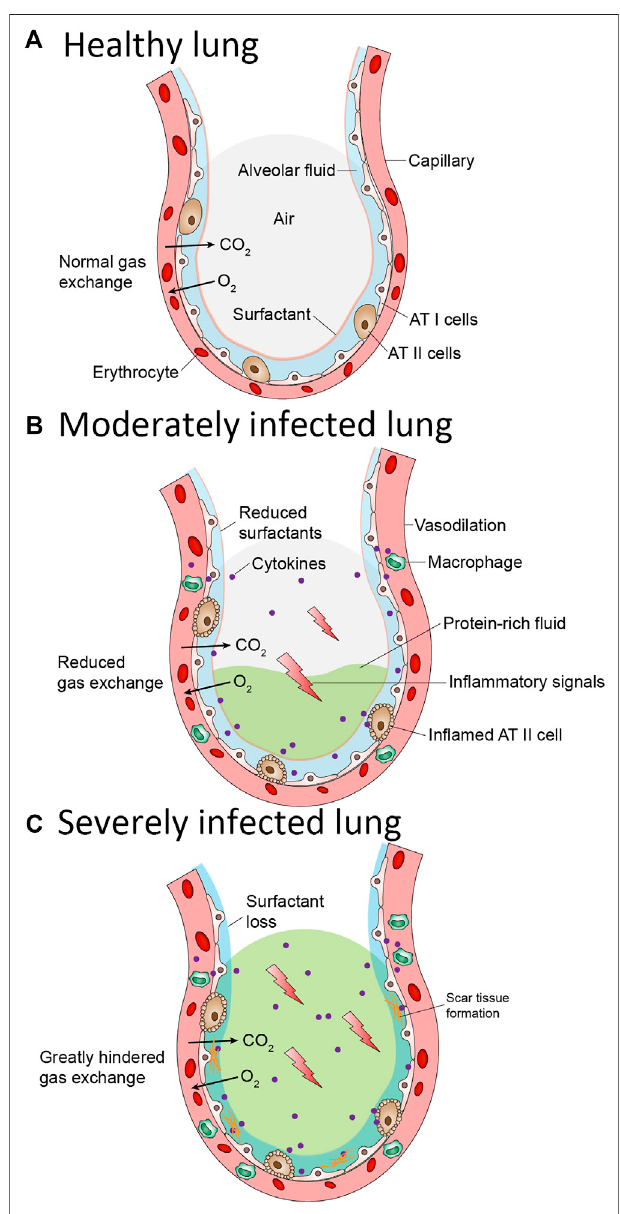
FIGURE 2 | Pathological changes in the lung alveolus during COVID-19 (A) Normal alveolus is wrapped with capillaries containing red blood cells. Oxygeninthealveolus isexchangedwithcarbon dioxideinthecapillaries. The alveolussurfacecontainsalveolarTypeIandTypeIIcells.TypeIcellsenables gasexchange.TypeIIcellssecretepulmonarysurfactant(PS).PSlinesthealveolus andpreventitfromcollapsing (B) Inamoderatelyinfectedlung,AlveolarTypeIIcells are in fl amed resulting in reduced pulmonary surfactant. Surface tension and pressure increase inside the alveolus affecting the gas exchange. Vasodilation of the capillary occurs resulting in the release of in fl ammatory cytokines and accumulation of protein-rich fl uid inside the alveolus (C) In severely infected lung, thealveolartypeIIcellsbecomemorein fl amedtherebyresultingincompletelossof pulmonary surfactant. Scar tissue on the alveolar surface began to form. The release of in fl ammatory cytokines is increased, and more protein-rich fl uid accumulate inside the alveolus. The oxygen/carbon dioxide exchange is greatly hindered and thus patients in this stage must undergo intubation as an aid to